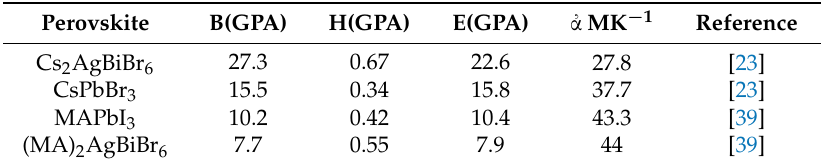
Table 2. Experimental values of bulk moduli B, hardness H, Young’s moduli E, and linear thermal expansion coefficient ἀ for four